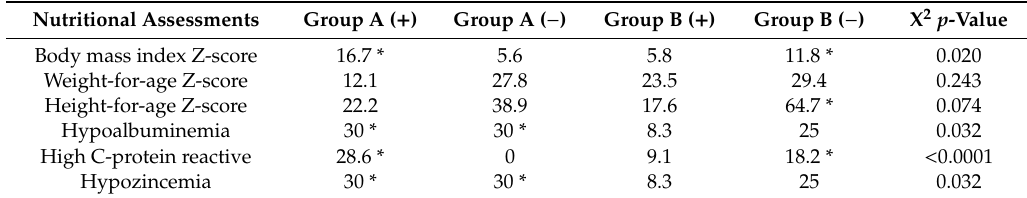
Table 6. Di ff erences between percentages of cases with positive or negative change by groups of zinc supplementation ( n = 35).